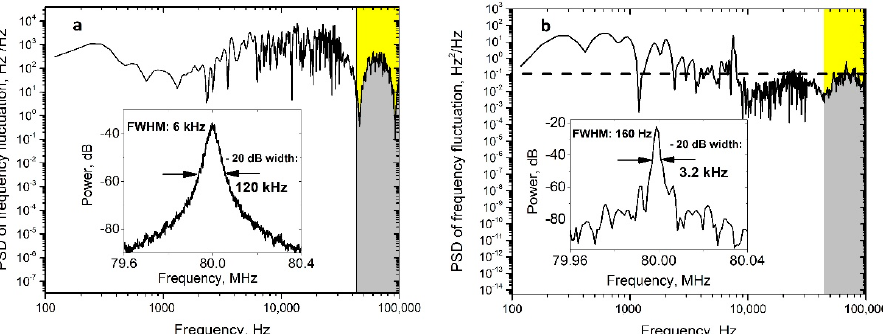
Figure 5. ( a ) Frequency noise PSD obtained for DFB laser in conventional ( a ) and hybrid ( b ) configu- ration. On the insets: RF beating spectra obtained by heterodyne technique.